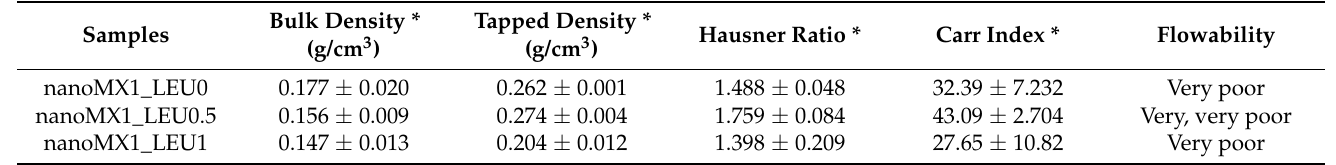
Table 6. Rheology properties of the samples.